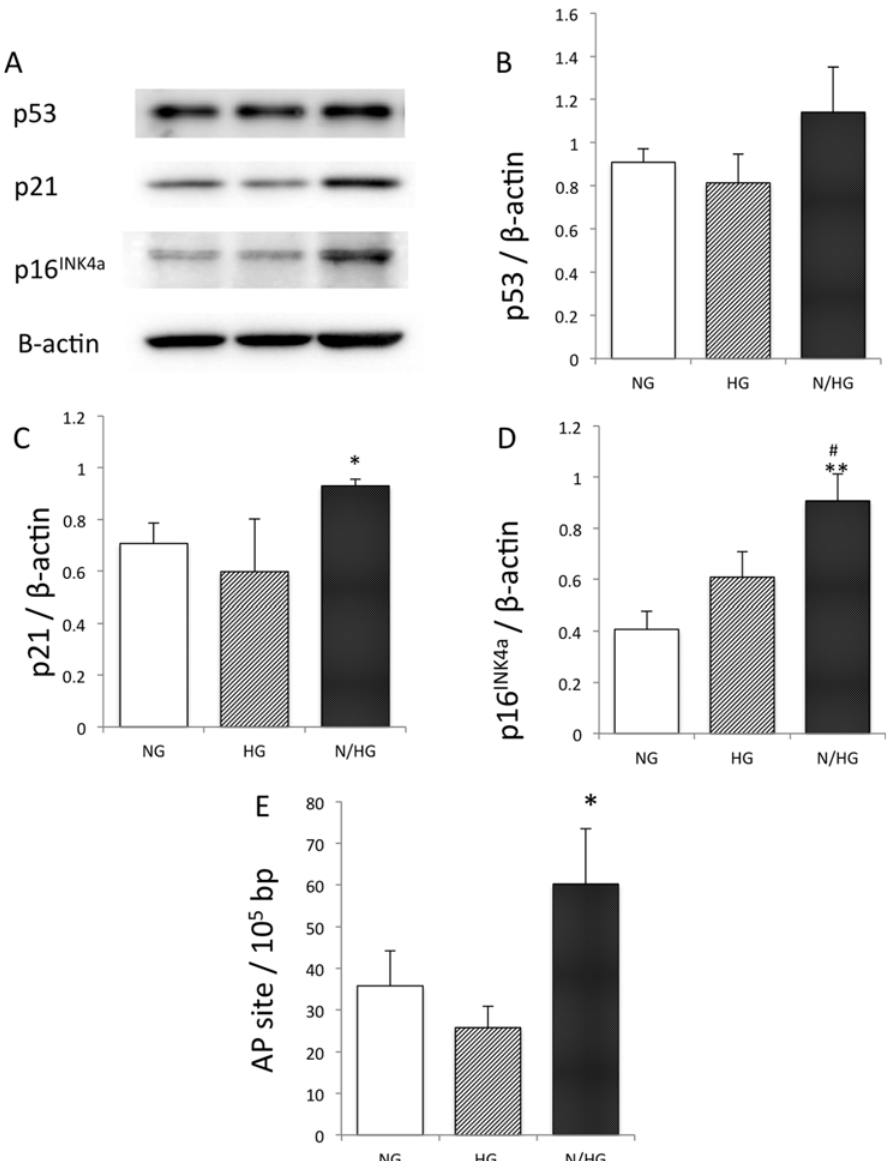
Fig 3. Effect of high glucose on p53, p21, p16 INKa , and DNA ladder on Apurinic/apyrimidinic (AP) sites. HUVECs were cultured with constant high glucose (HG) and intermittent glucose (N/HG) introduced in Fig 1. Namely, N/HG was stimulated twice with HG (at 4-hour intervals) for a total of 4 hours daily (9 a.m. to 11 a.m., 3 p.m. to 5 p.m.), and was cultured in NG in other time of the total 4-hour HG stimulation. (A)-(D): Effect of high glucose on p53, p21, p16 INKa protein. (E): Effect of continuous and intermittent high glucose on endothelial DNA damage on Apurinic/apyrimidinic(AP) sites. * p < 0.05; ** p < 0.01 vs. NG; #p < 0.05 vs. HG. The values of the three independent experiments are mean ±